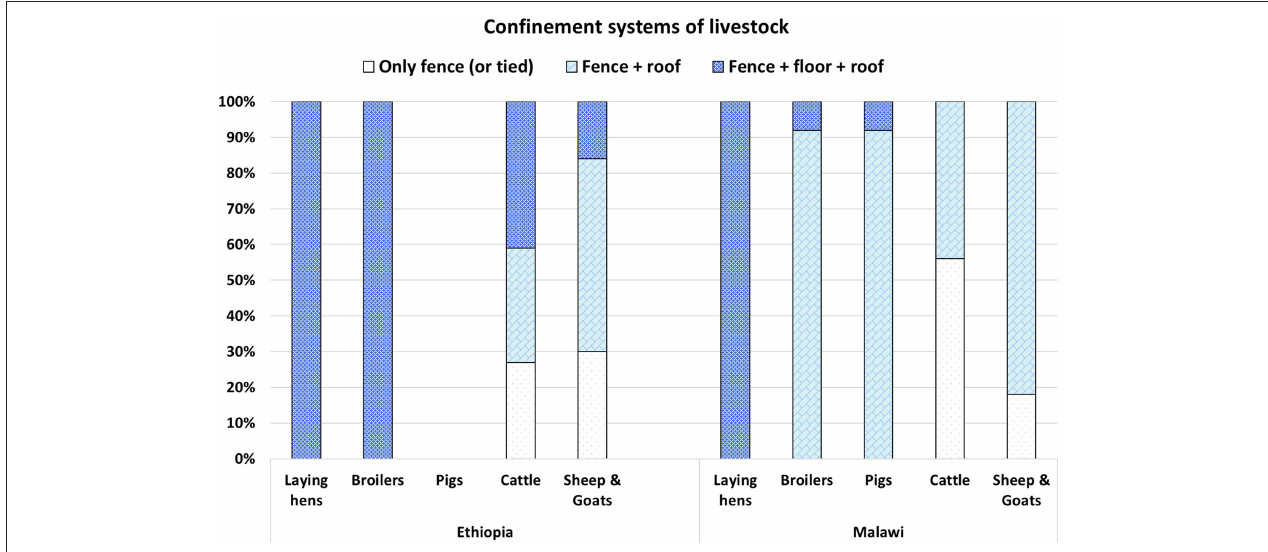
FIGURE 2 | Proportion of farms in Ethiopia and Malawi keeping their animals in different confinement systems including fencing, roofing and flooring